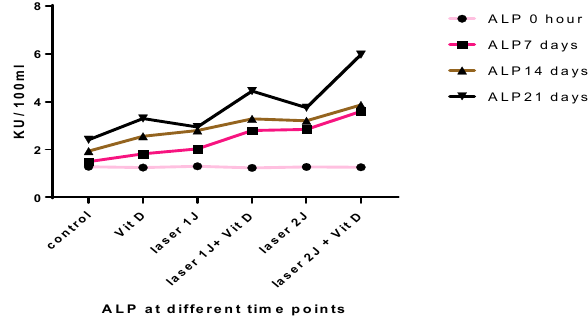
Figure 8: ALP enzyme activity levels measured at 0, 7, 14, and 21 days with a highly significant difference between the 2 J/cm 2 group compared to the 1 J/cm 2 (p < 0.001) on day 21. Moreover, the 2 J/ cm 2 and culture with vitamin D group showed highly statistically significant difference than the control group (p < 0.0001). Data were expressed as mean ± SD; a P-value <0.05 was significant. (*) denotes significant difference versus control. (#) denotes significant difference versus vitamin D.($) denotes significant difference versus laser 1 J/cm 2 . (@) denotes significant difference versus laser 1 J/cm 2 + vitamin D. (&) denotes significant difference versus laser 2 J/cm 2